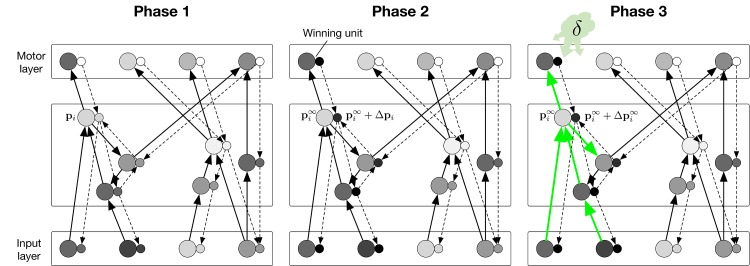
Illustration of the learning phases.Each regular unit (large circles) is accompanied by an accessory unit (small circles), which are hypothesized to be situated in the same cortical column. In phase 1, the sensory input leads to a stable state p
∞ of the regular units (note that we only illustrated the excitatory connections in this scheme) and the model represents estimates of the value of all the actions in the output layer. In phase 2, the winning output unit injects extra activity into the accessory network. The strength of the connections of the accessory network is reciprocal (equally strong) to that of the regular network. Accessory units that are paired with a regular unit that has a strong impact on the activity of the winning unit exhibit a strong increase in activity Δp during this phase. In phase 3 the changes in synaptic strength depend on Δp and a neuromodulatory signal that encodes the reward-prediction error δ (green cloud in phase 3; right panel).